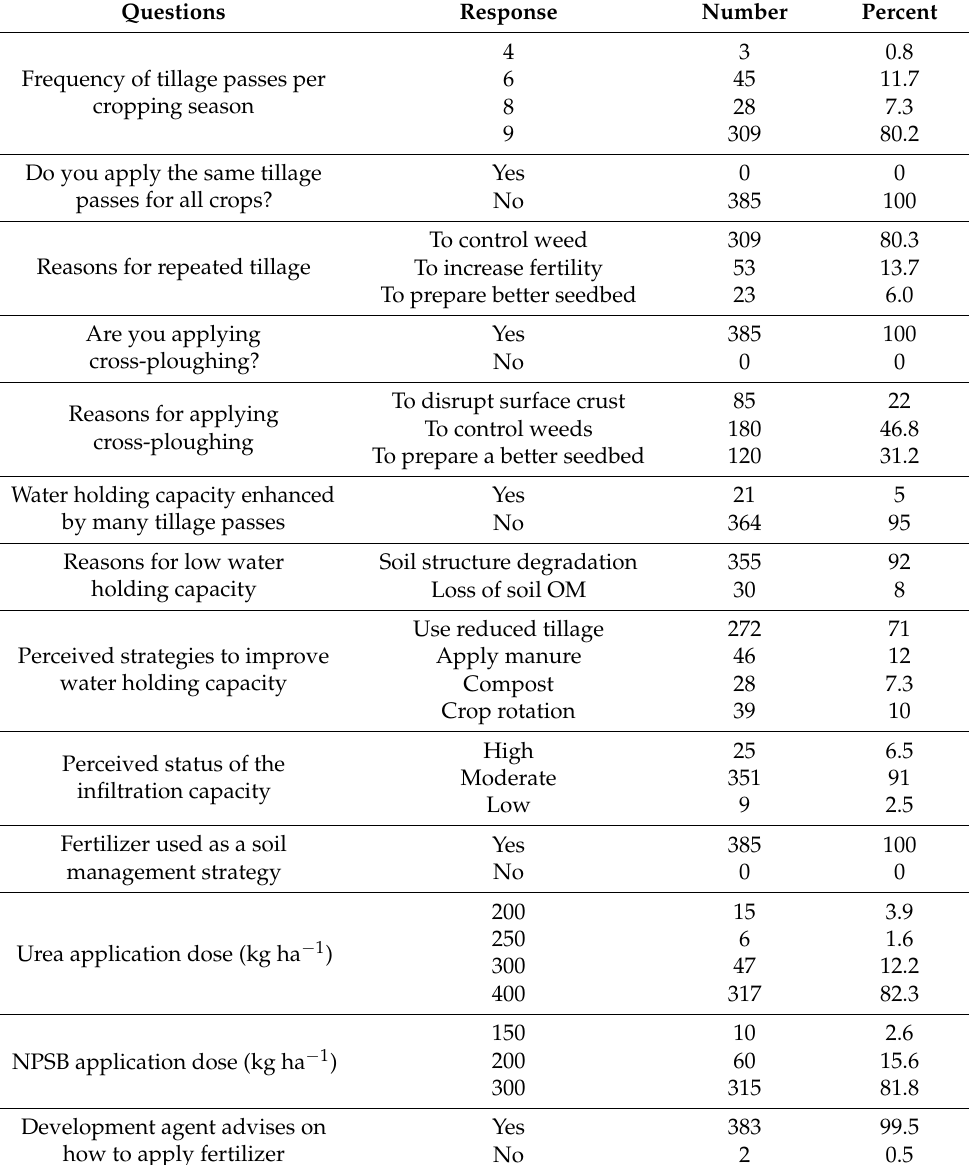
Table 5. HHs perceived soil management